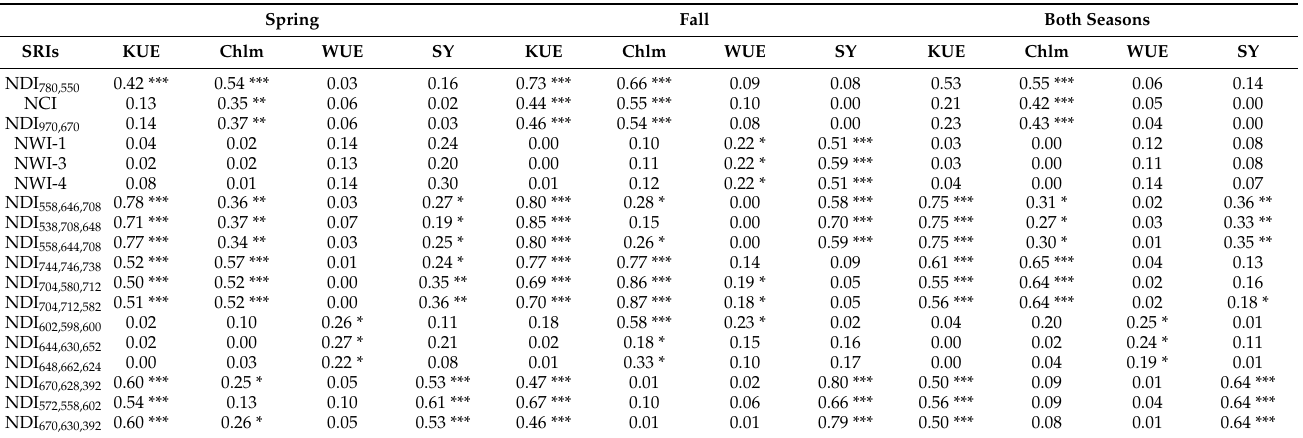
Table 6. Relationships of linear regression of four parameters (potassium-use efficiency (KUE), chlorophyll meter (Chlm), water-use efficiency (WUE), and seed yield (SY)) with several SRIs of squash expressed as determination